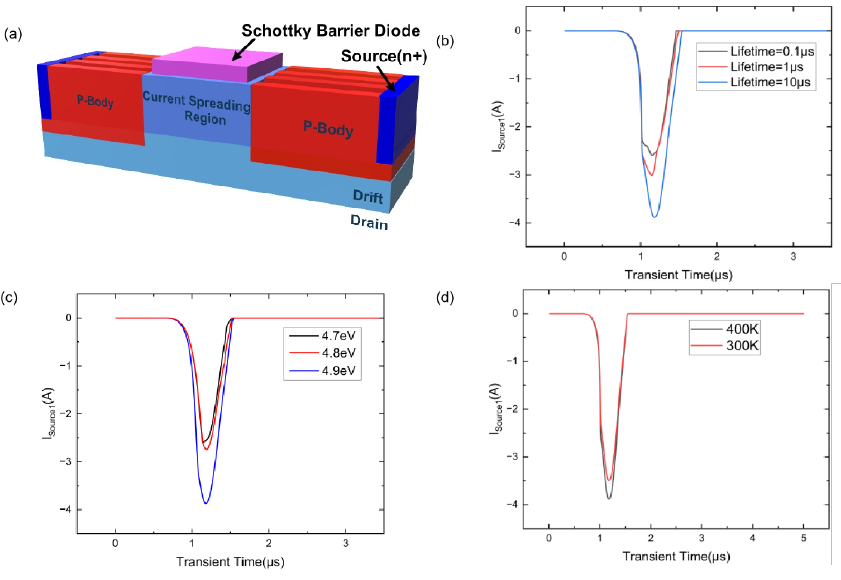
Figure 6. ( a ) Schematic view of basic SBD structure. Recovery characteristics with different ( b ) life- times, ( c ) work functions, and ( d )